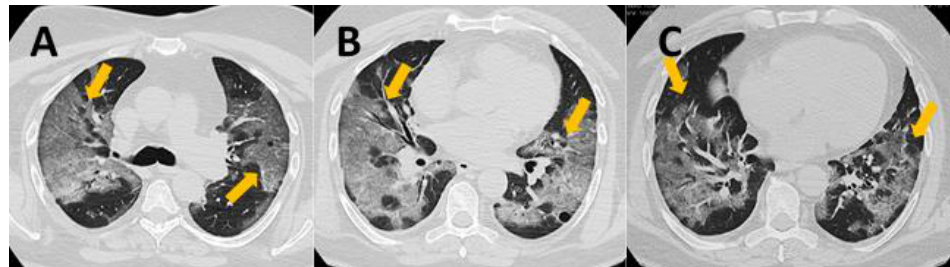
Figure A1. The example of CT changes in patient with critical COVID severity score 20 — 4 points (50 to 75% of lung tissue involvement) for the each of lung lobe. ( A ) axial scan at the level of upper lobes; ( B ) axial scan at the level of middle lobe on the right side, lingua on the left side and the upper segments of lower lobes; ( C ) axial scan at the level of the basal segments of the lower lobes. The yellow arrows points ground-glass and crazy paving opacifications.